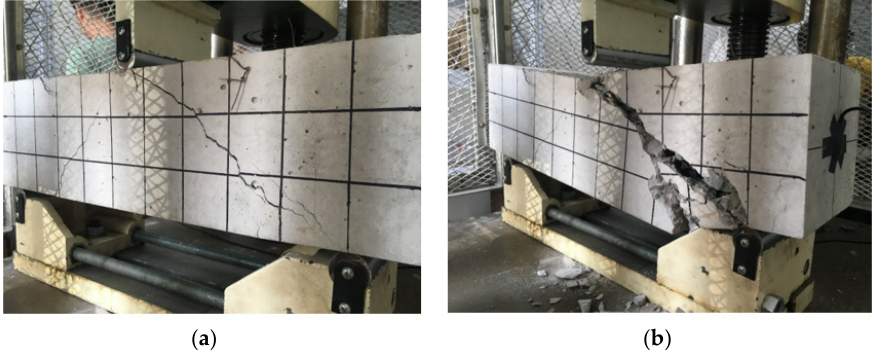
Figure 7. Failures of the specimen ( a ) cracks at load of 20 kN, ( b ) collapse at load of 53.5 kN.